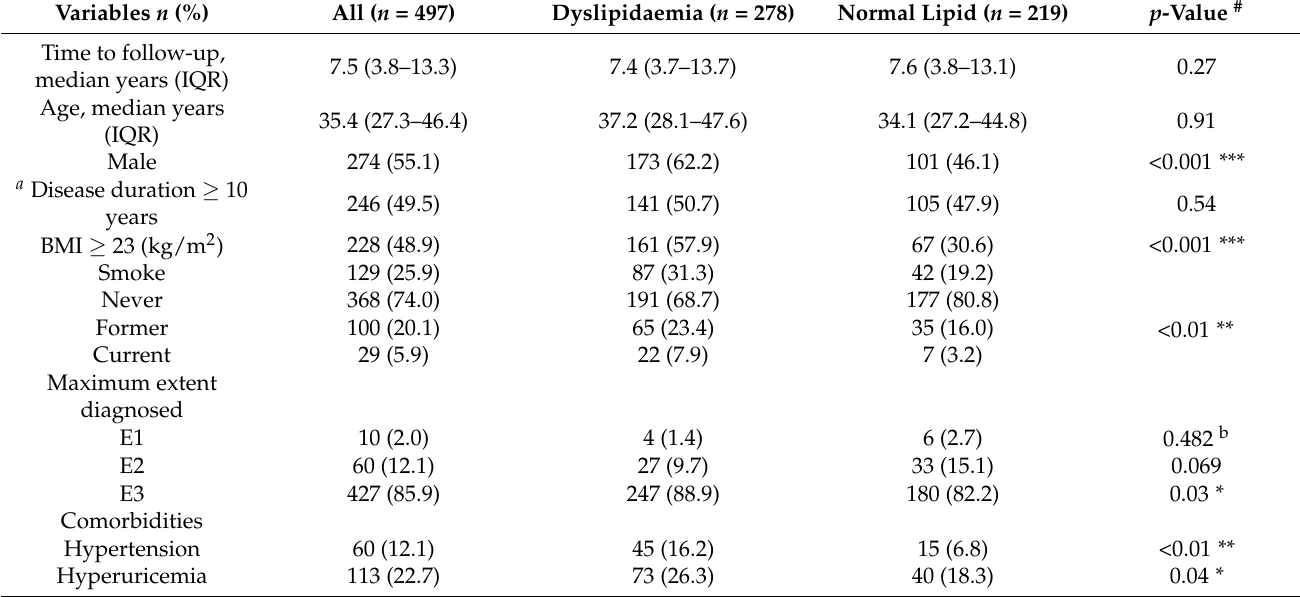
Table 1. Demographic and clinical characteristics of patients with dyslipidaemia and normal lipid